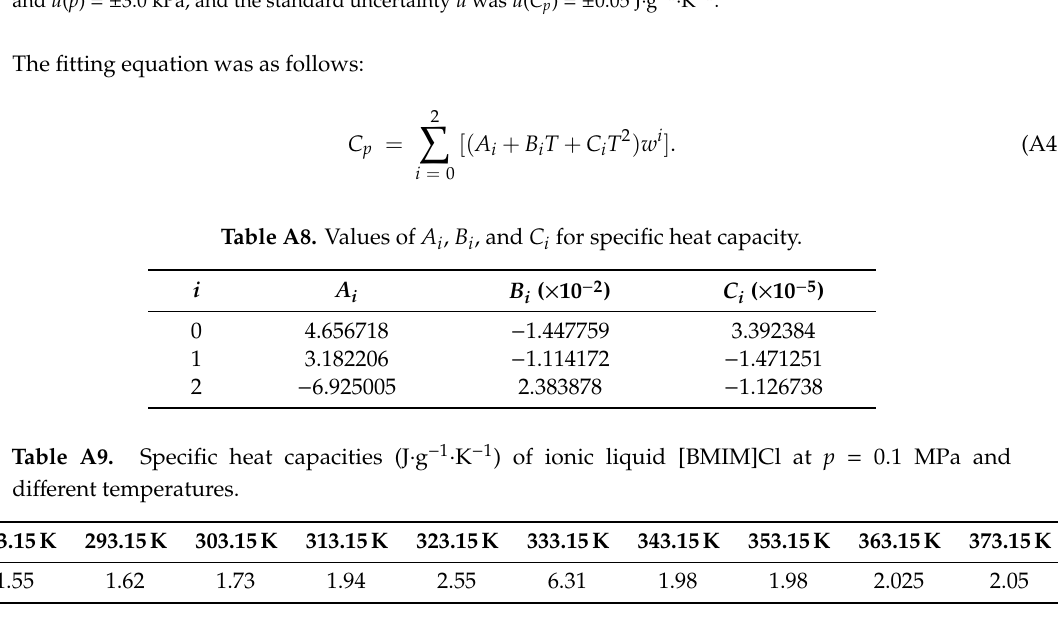
Table A10. Dissolution enthalpies (kJ · kg − 1 ) at various mass fractions w for LiBr–[BMIM]Cl / H 2 O at 313.15 K and p = 0.1